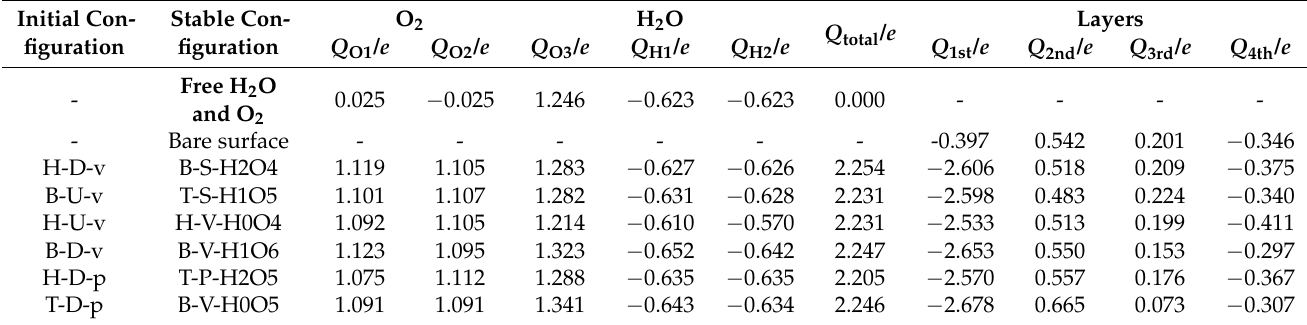
Table 3. Net charge distribution of co-adsorption stable configuration obtained when O 2 is preferentially adsorbed. Initial Con- Stable figuration